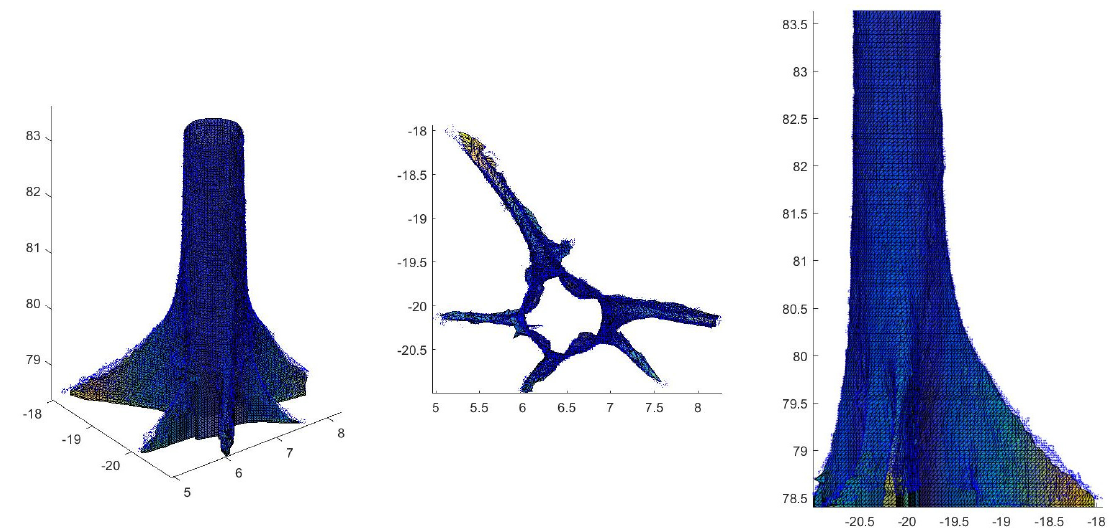
Figure 3. Buttresses modelling of a Hymenolobium flavum tree. The bottom part of the stem was modelled with a triangular mesh instead of cylinders. The mesh volume replaced the volume of the